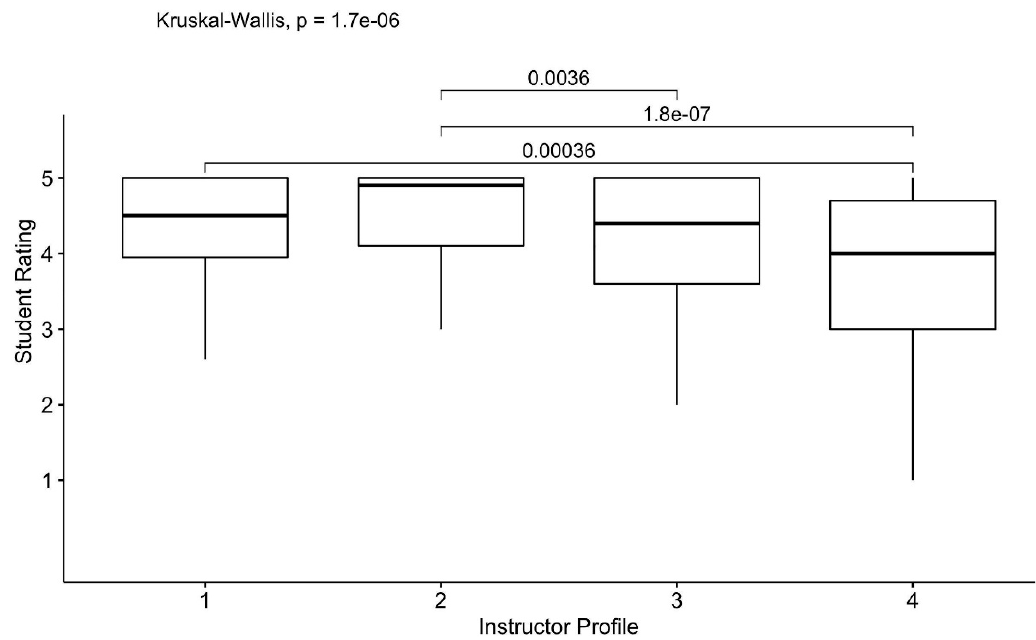
Figure 5. Sensitive Feedback ratings according to instructor profile. Instructor 1 is a native speaker from Spain, Instructor 2 is a native speaker from Latin America, Instructor 3 is a Heritage Speaker of Spanish, and Instructor 4 is an L2 Spanish speaker.